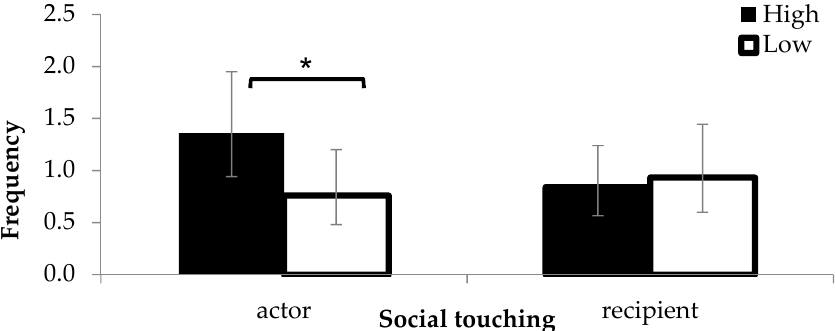
Figure 1. The number of social touching events observed as an actor or as a recipient (back- transformed means). Error bars indicate 95% Cis (confidence intervals). *: p < 0.05.